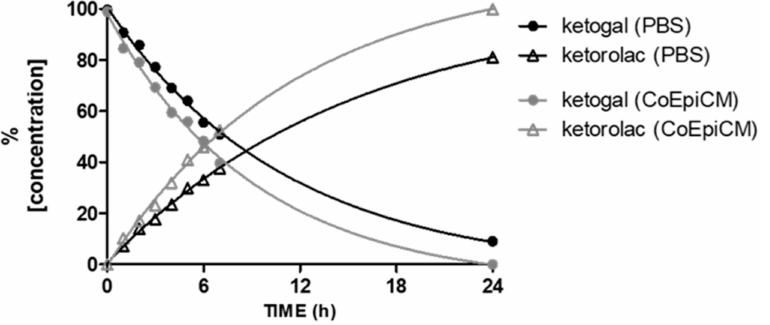
Figure 1. Stability of ketogal in PBS and CoEpi cell medium. Results are expressed as mean values ( n =